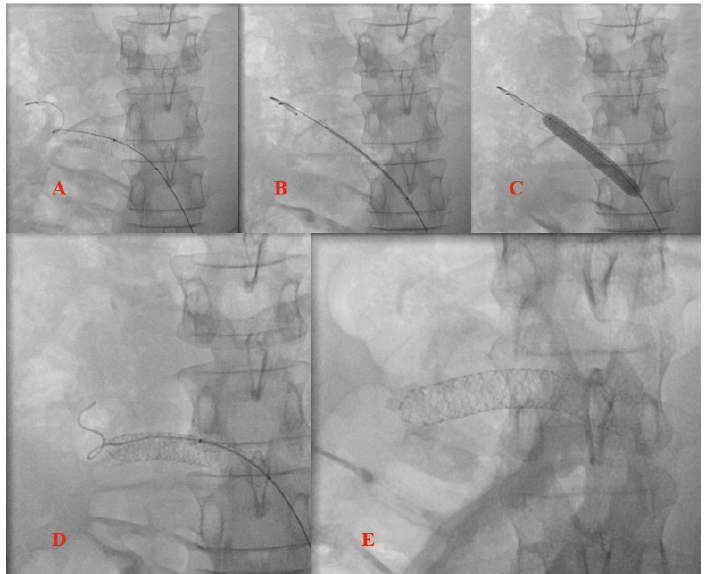
Figure 4. Left renal vein angioplasty optimization of the initial angioplasty. Note that the images are mirrored because the patient was positioned upside down on the operating table for jugular access. ( A ) Initial stent repositioning and post-dilation. ( B ) Second stent positioning and ( C ) stent deployment. ( D ) Second stent post dilation. ( E ) Final